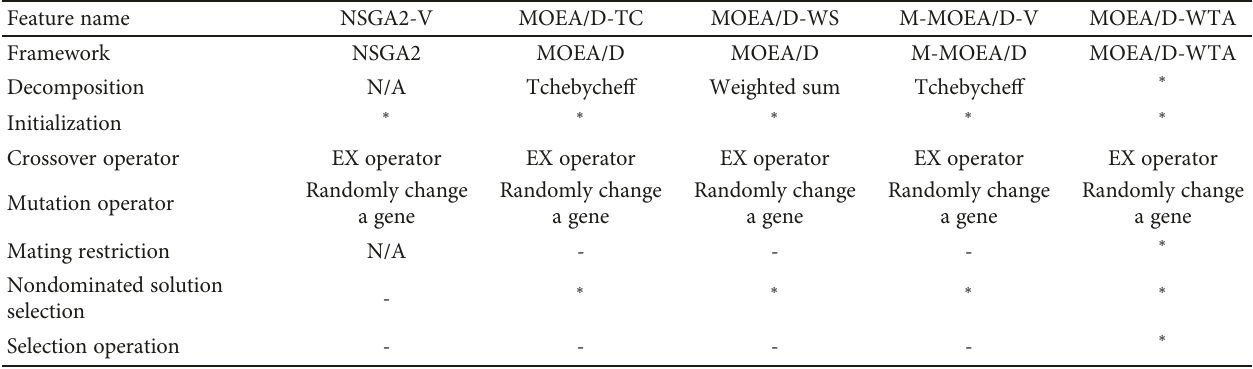
Table 2: The main features of MOEAs. N/A indicates that the feature is not available for the corresponding algorithm. ∗ presents that the method of the feature is the proposed method in this paper. - indicates that the method of the feature is the same as the corresponding